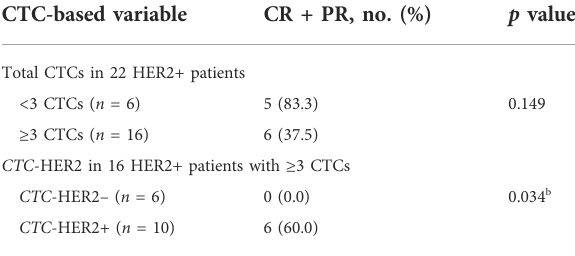
TABLE 3 Correlation analysis of baseline CTC enumeration or CTC - HER2 phenotyping with objective response after anti-HER2 therapy.